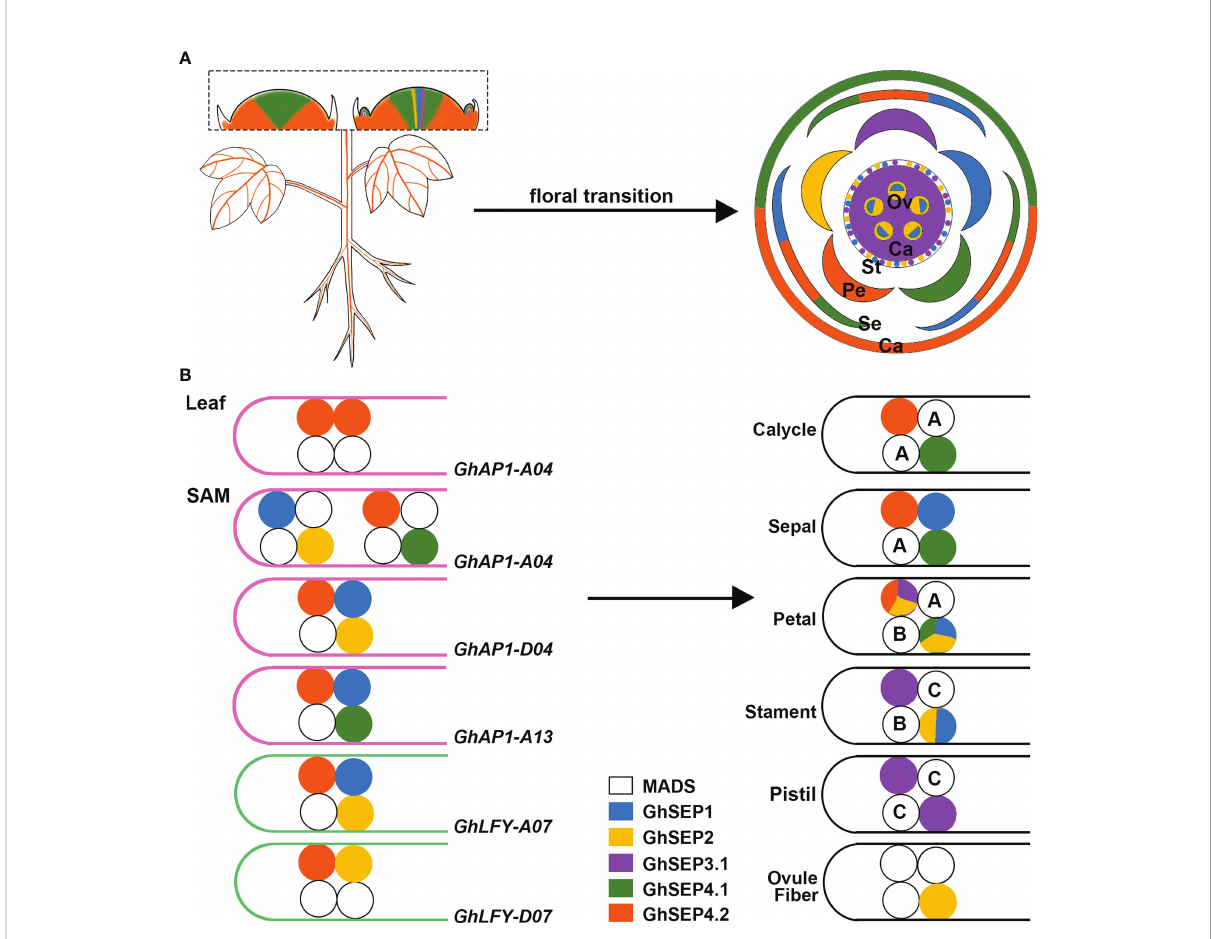
FIGURE 7 The proposed model of the GhSEP regulatory mechanism. (A) Spatial and temporal expression dynamic of GhSEP genes during reproductive growth. Ca, calycle; Se, sepal; Pe, petal; St, stamen; Pi, pistil; Ov, ovule. (B) Speculation of protein complexes involving different GhSEP proteins and their target loci. A, B, and C indicate the ABC genes. In the model, GhSEP genes are transcribed sequentially in the leaf and SAM resulting in dynamic protein tetramers containing other MADS proteins to directly regulate different target genes to promote fl oral transition and regulate the reproductive growth in the